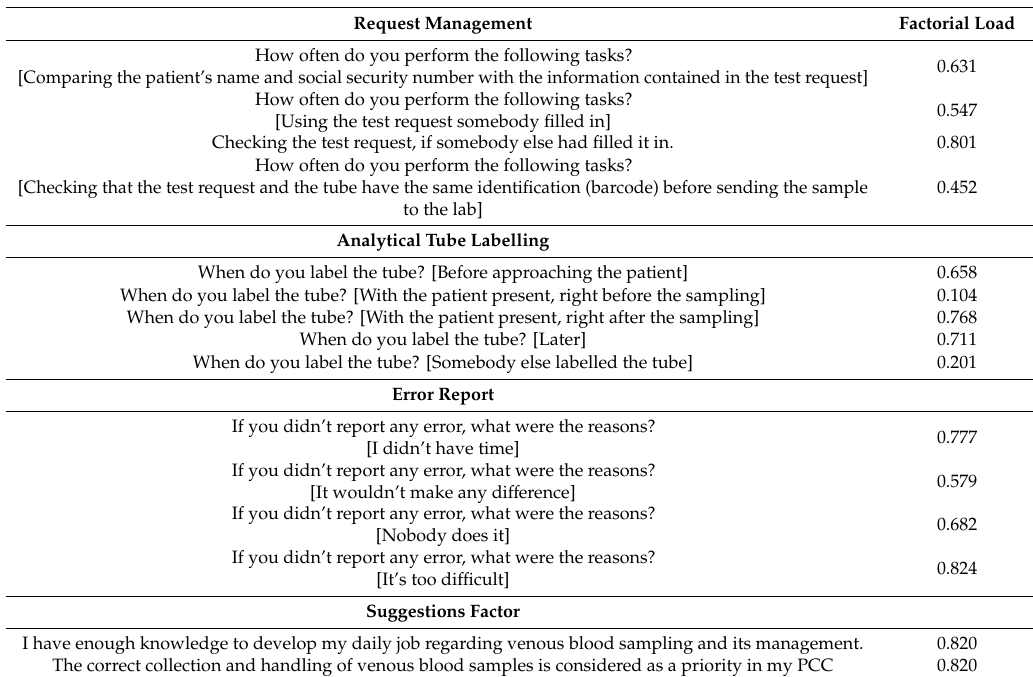
Table 2. Standardised factorial load of “Request Management”, “Tube Labelling”, “Error Reporting”, and “Suggestion Factors”. (Source: self-prepared).